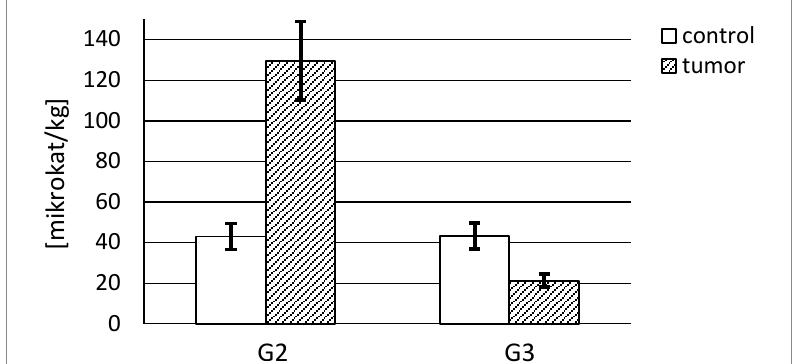
Figure 9. MMP-10 specific activity in human kidney tumor (G2 grade and G3 grade) and respective control tissue. p < 0.001 - cancer vs. respective control kidney; p < 0.001 G3 grade vs. G2 grade human kidney cancer.